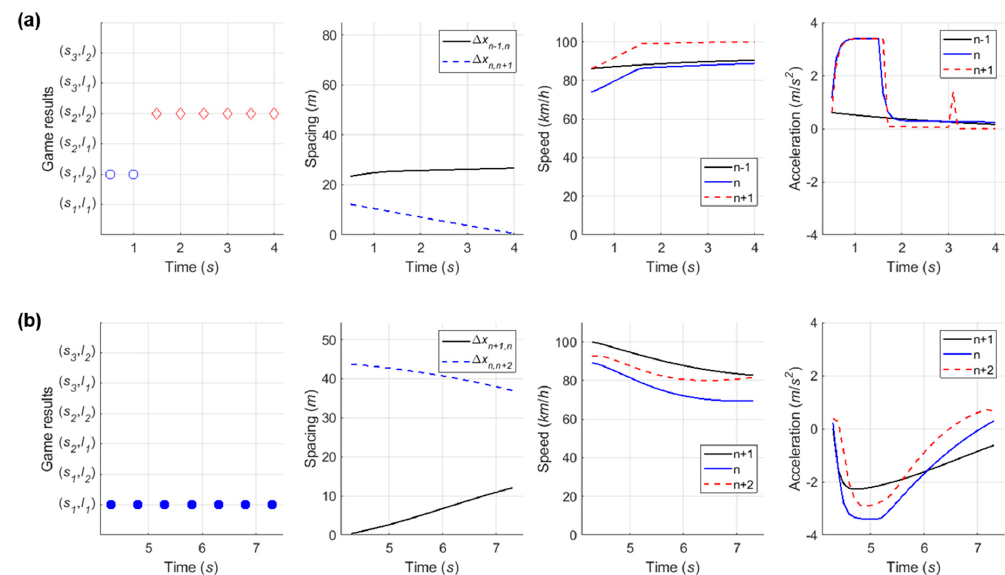
Figure 22. Graphical representation of simulation results in case 4.